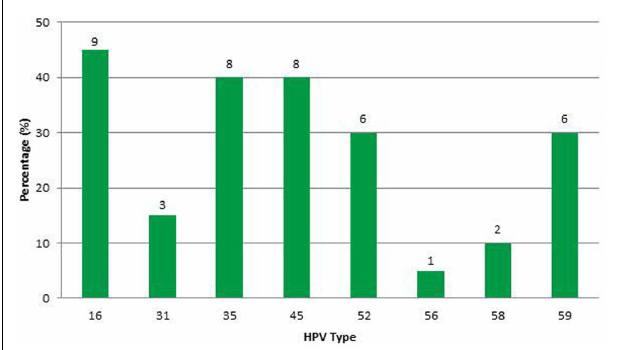
Table 2 | Patients’ characteristics ( n = 23) .